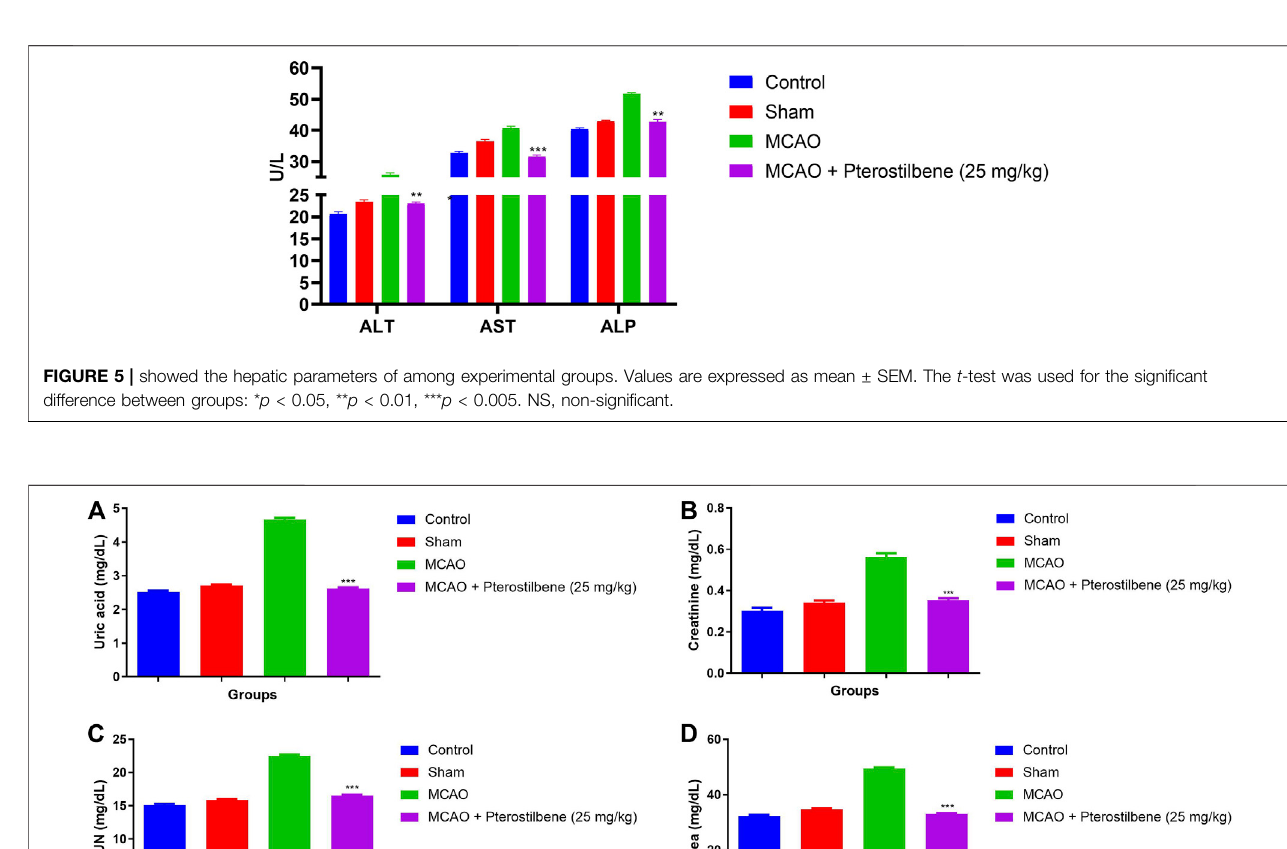
( Figure 12B ) as compared to different group. MCAO group treated with the pterostilbene signi fi cantly ( p < 0.001) suppressed